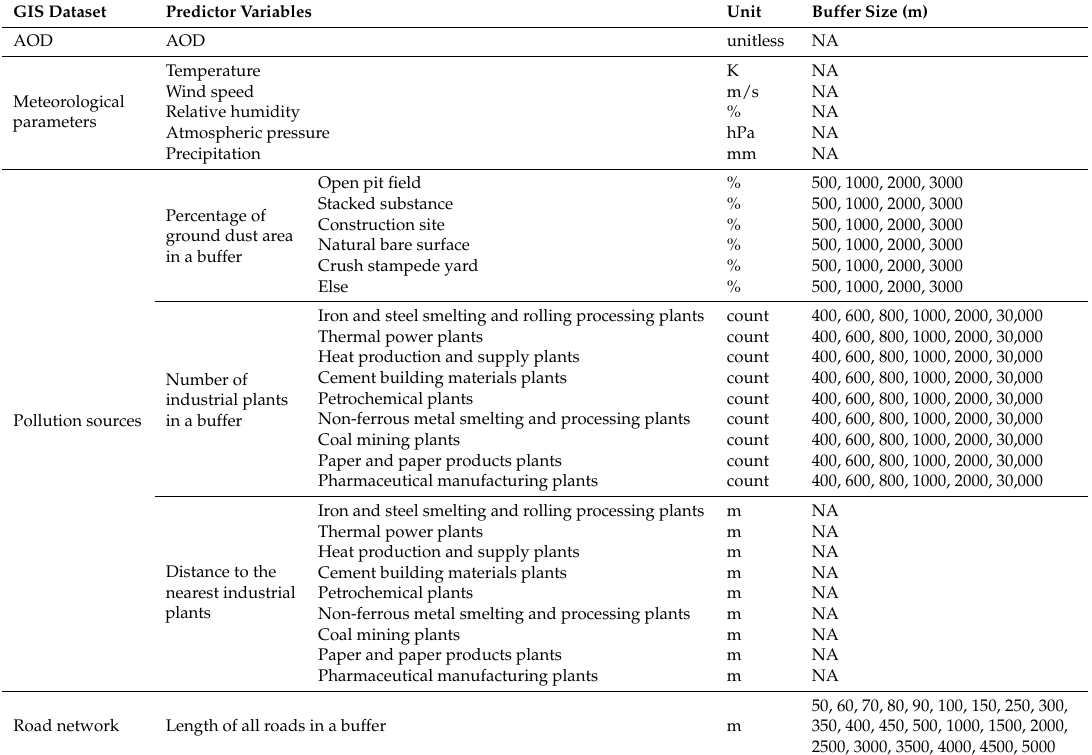
Table 1. Potential predictor variables for GAM and LUR